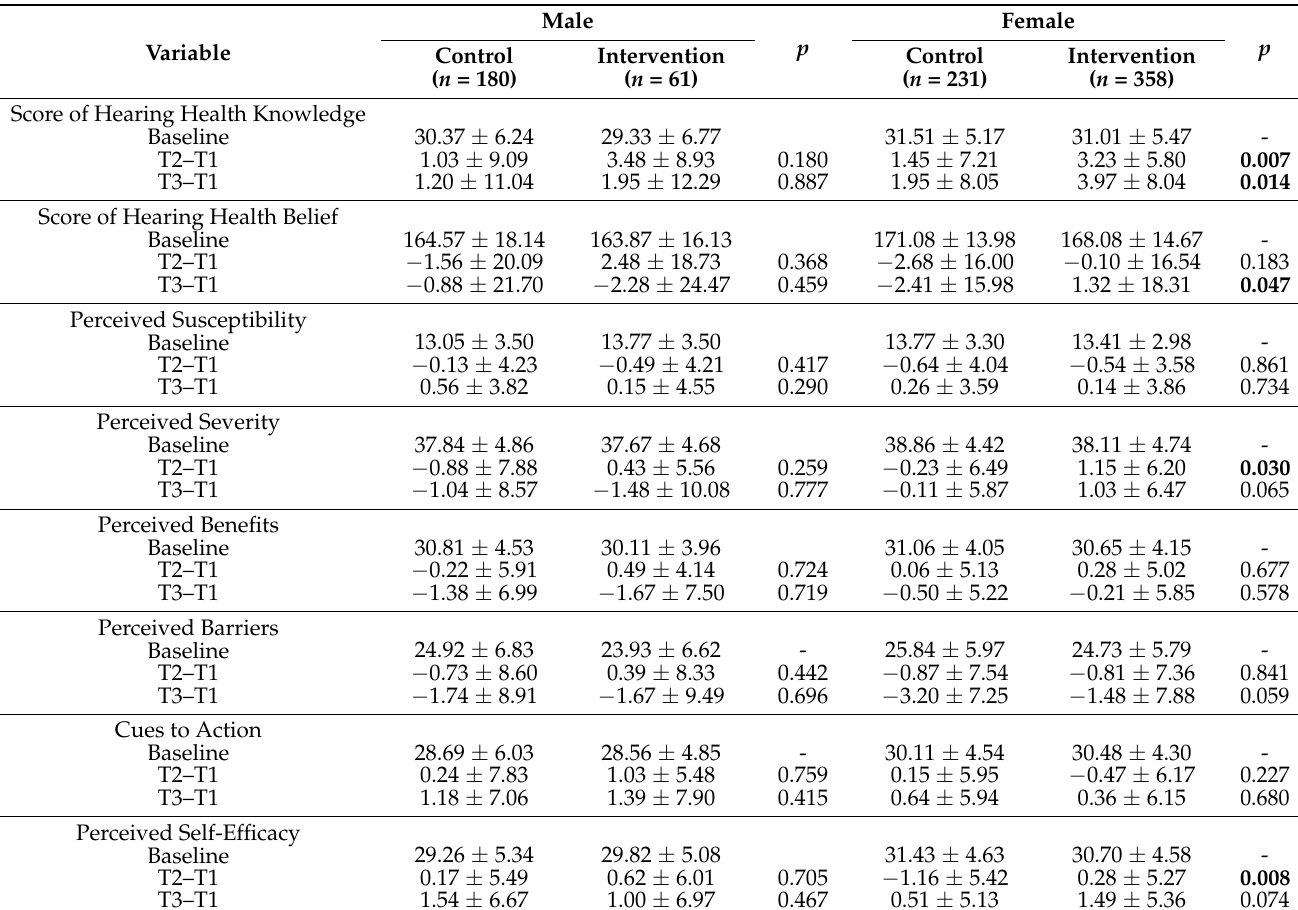
Table 2. Comparison of hearing health knowledge and belief before and after intervention in male and female students.